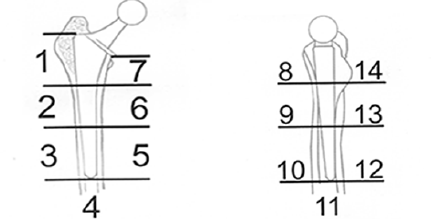
Figure 3 : Stem osseointegration A: Good B: Satisfactory C: Unsatisfactory (unstable component)